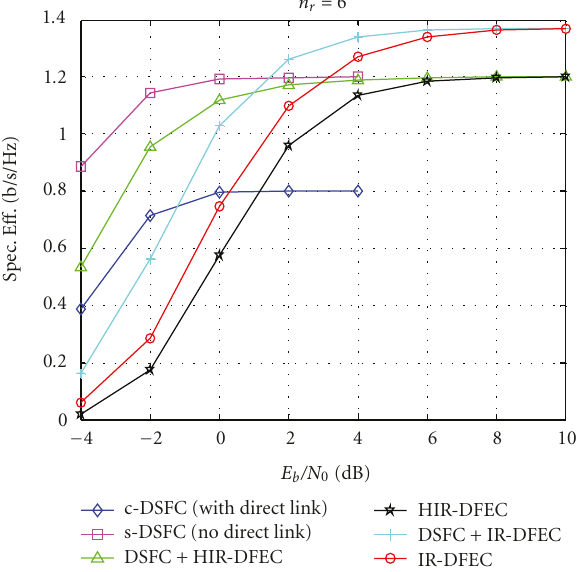
Figure 12: Spectral e ffi ciency versus E b /N 0-directlink —scenario D2— n d = n r = 2.